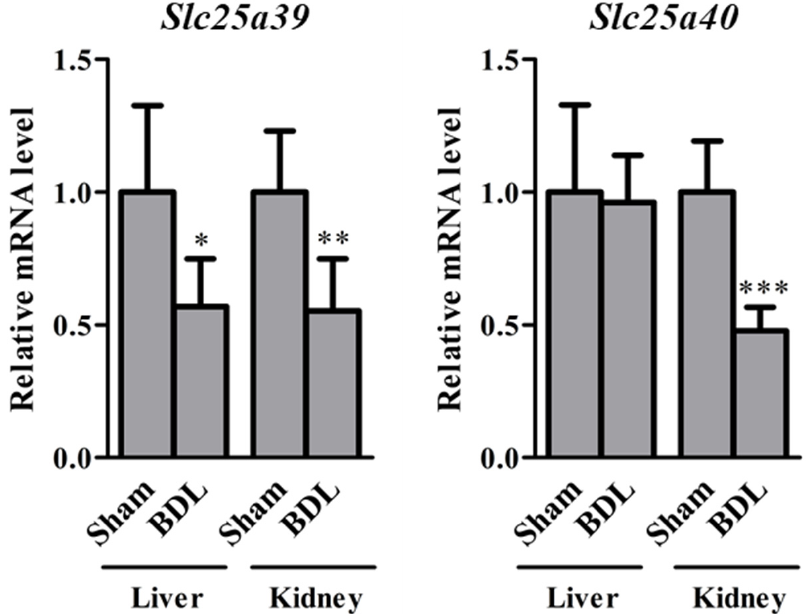
Figure 1. Relative mRNA levels of Slc25a39/40 in the liver and kidneys of sham and bile duct ligation (BDL) mice. The results are expressed as the mean ± S.D. of each group (n = 5). Significant differences (* p < 0.05, ** p < 0.01, and *** p < 0.001) between sham and BDL mice were observed.